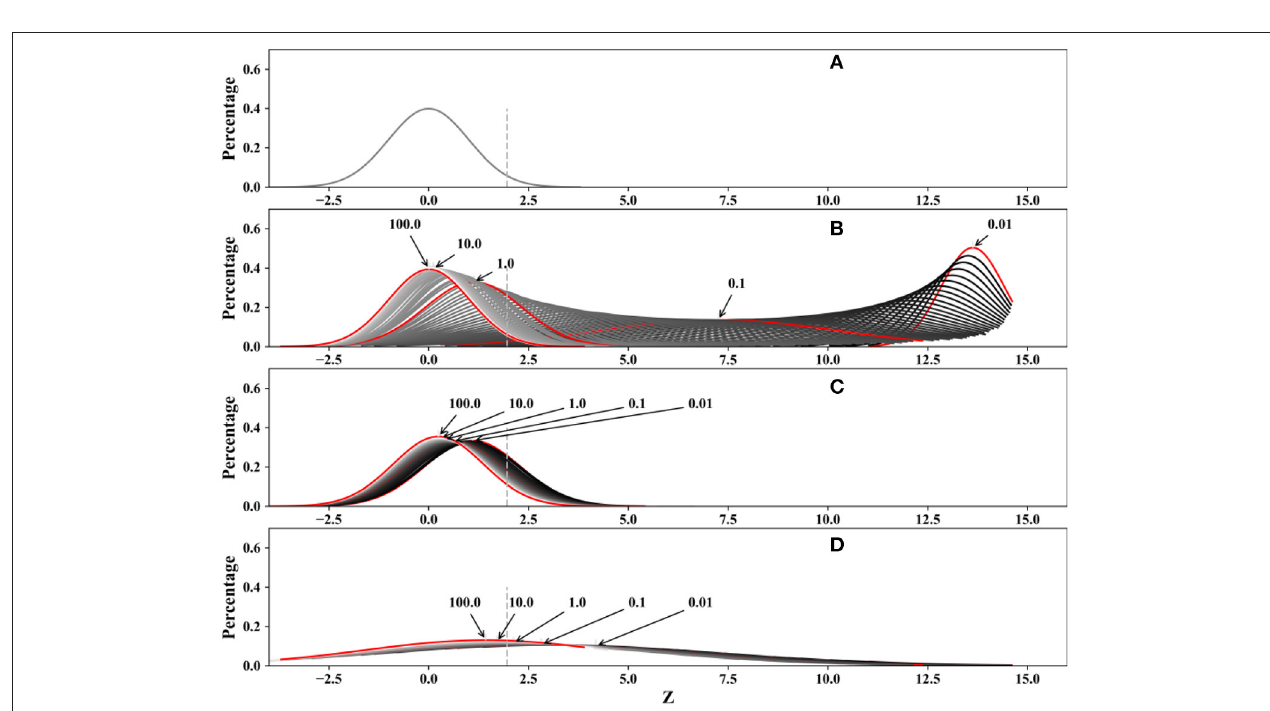
FIGURE 6 | Comparison of the distribution of test statistics against different PSDs with sample lengths equal to 100. The critical region is marked by the dashed line. (A) Slope value 0; (B) slope value 0.001 – 0.1; (C) slope value = =